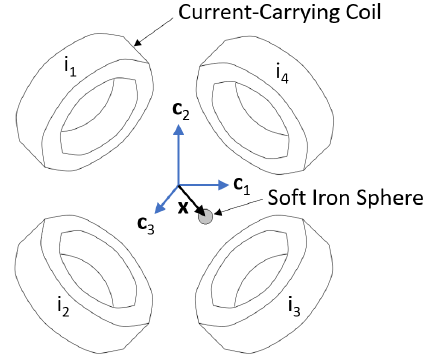
Figure 1. Magnetic manipulation system acting on a magnetically permeable